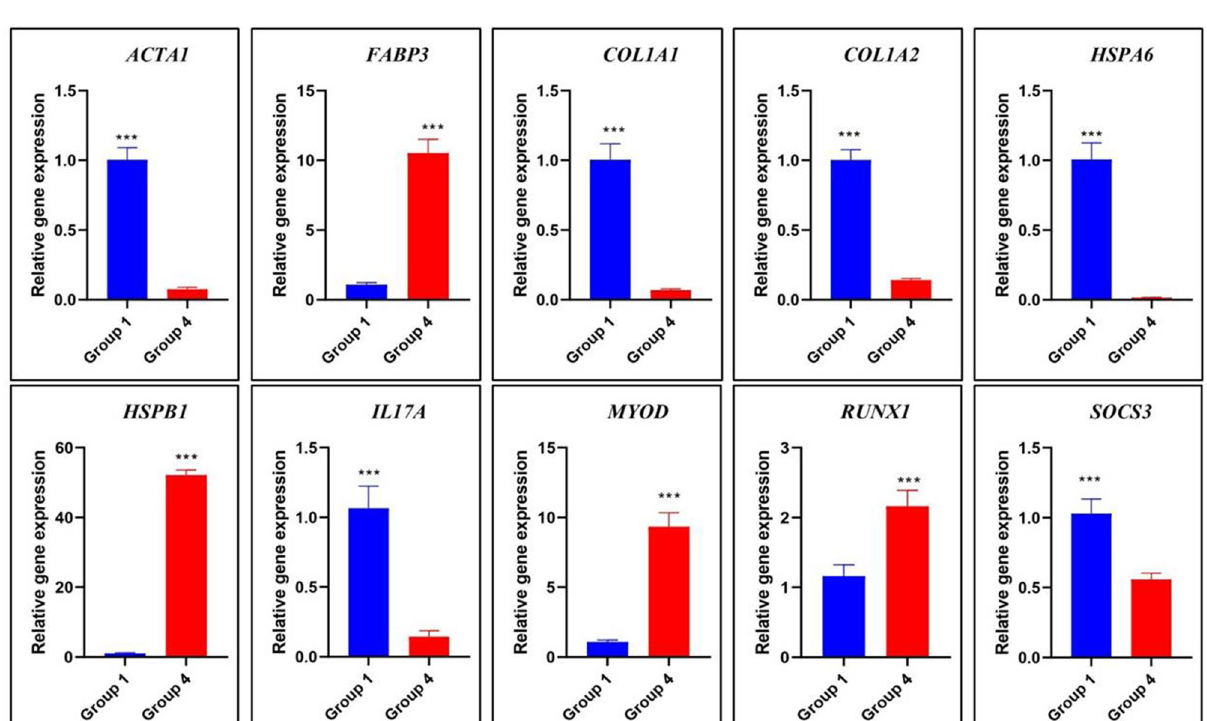
Figure 7. Relative expression of differentially expressed genes between Group 1 and Group 4 by quantitative PCR. Group1 = 2 tooth stage or 1 years; Group 4 = 8 tooth stage or 3.5–4